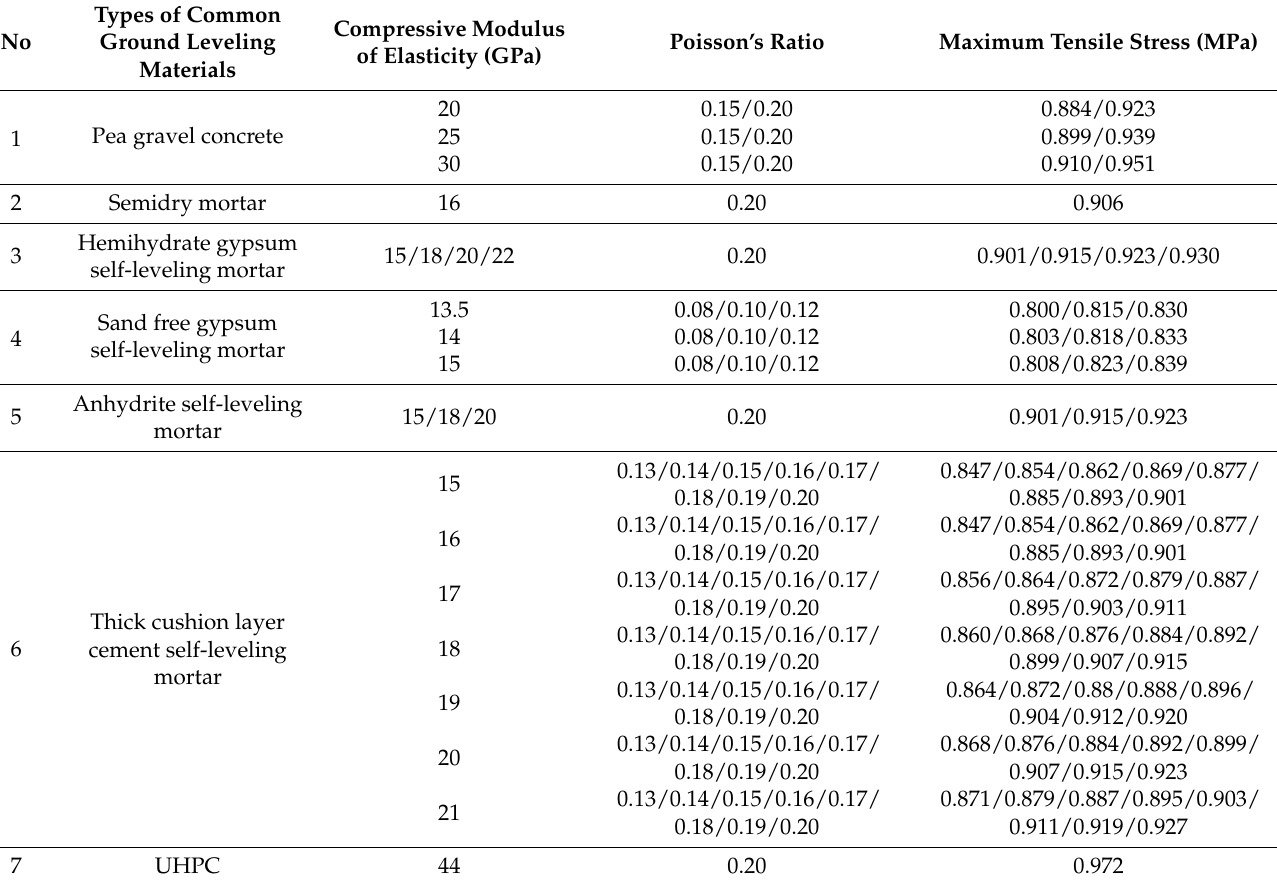
Table A1. Summary of maximum tensile stress of common functional layers’